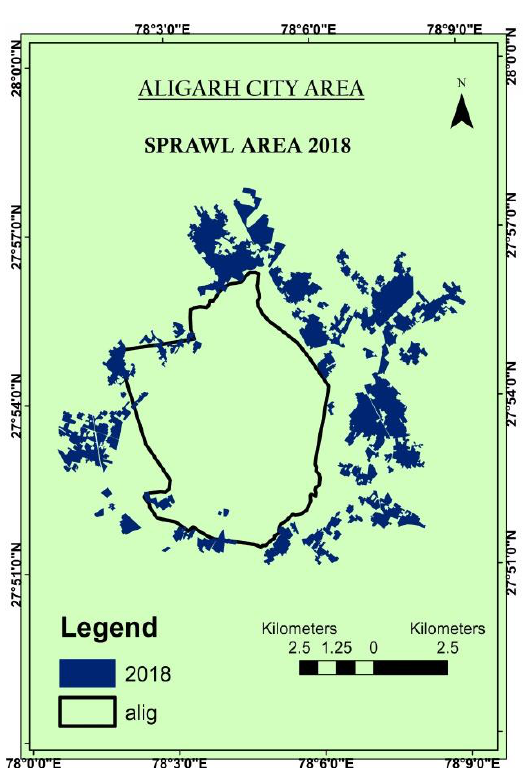
Fig 4 . Urban sprawl mapped for the year 2011.